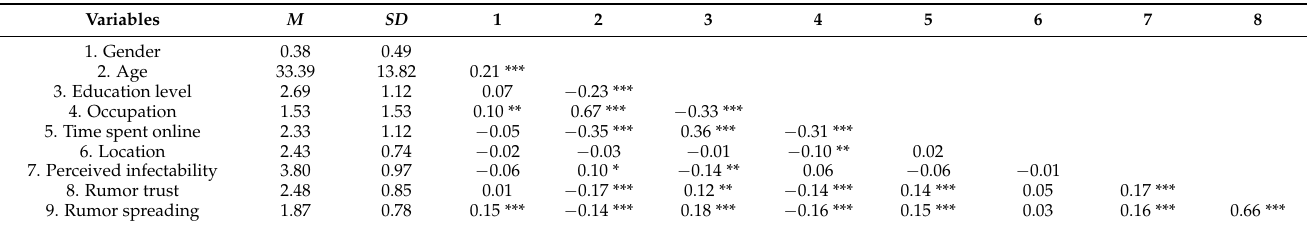
Table 1. Descriptive statistics and correlations among variables in Study